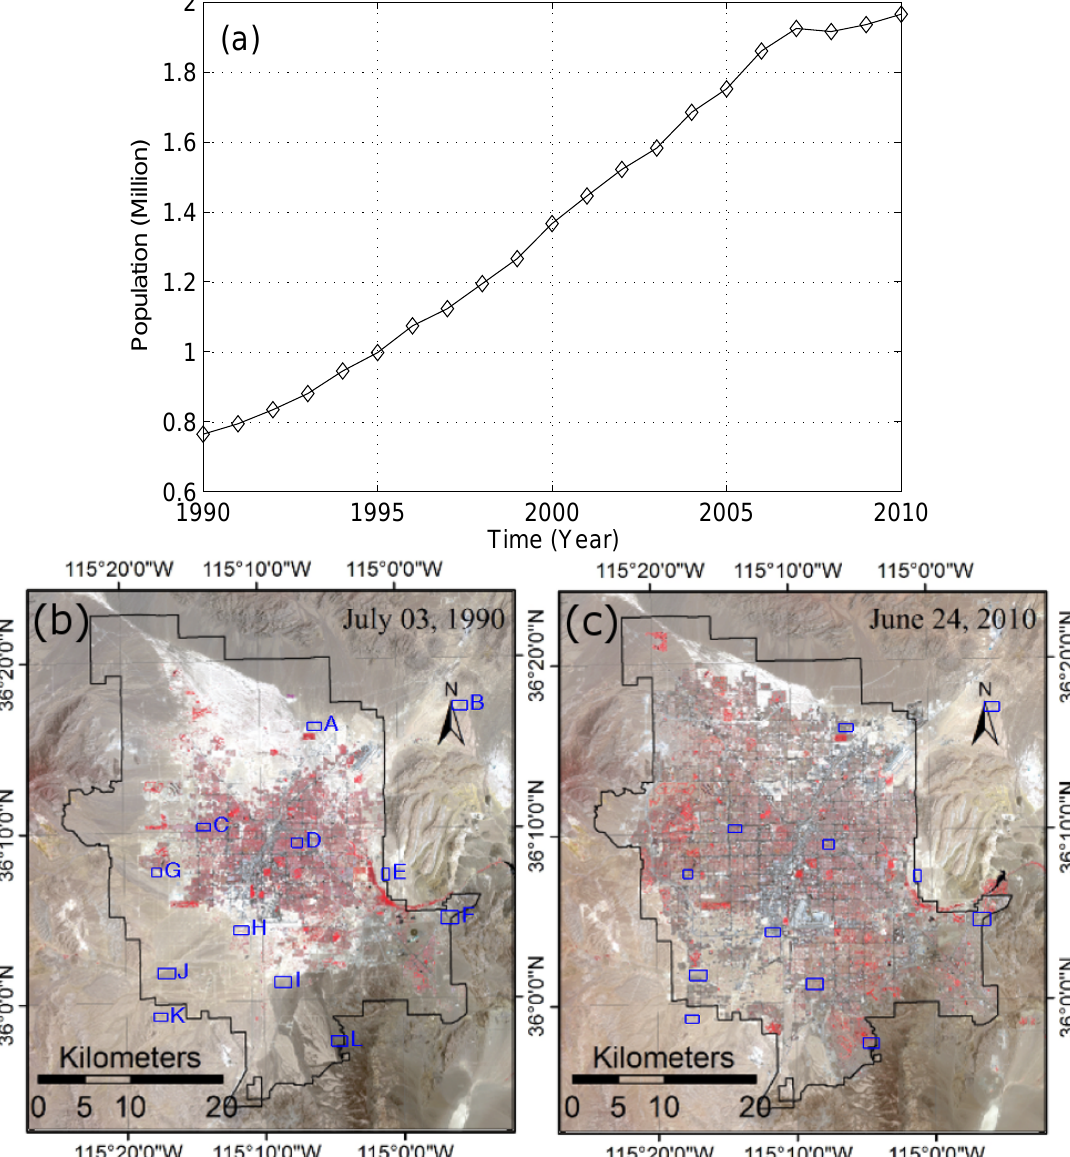
Figure 1. ( a ) Plot showing Clark County population growth trend and ( b , c ) corresponding expansion in Las Vegas urban footprint revealed by Landsat TM images. Overlaid regions of interest are used to analyze land cover change and its impact on